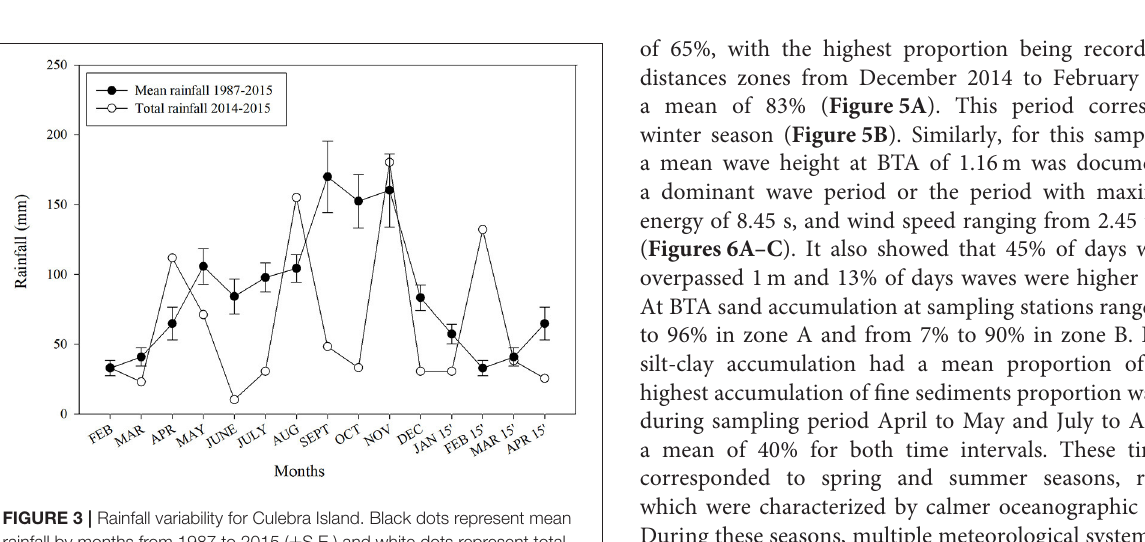
FIGURE 2 | Sedimentation rate ( ± S.E.) for both sites (A) , sedimentation rate at BTA by distance zones (B) , sedimentation rate at PSO by distance zones (C) , terrigenous rate for both sites (D) .